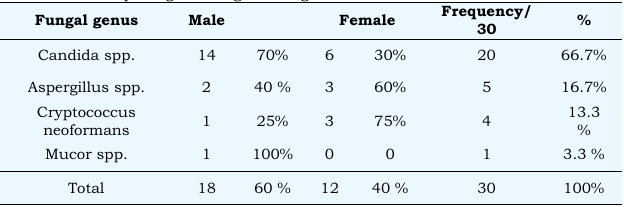
Table 2 Distribution of pathogenic fungal among both sex Fungal genus